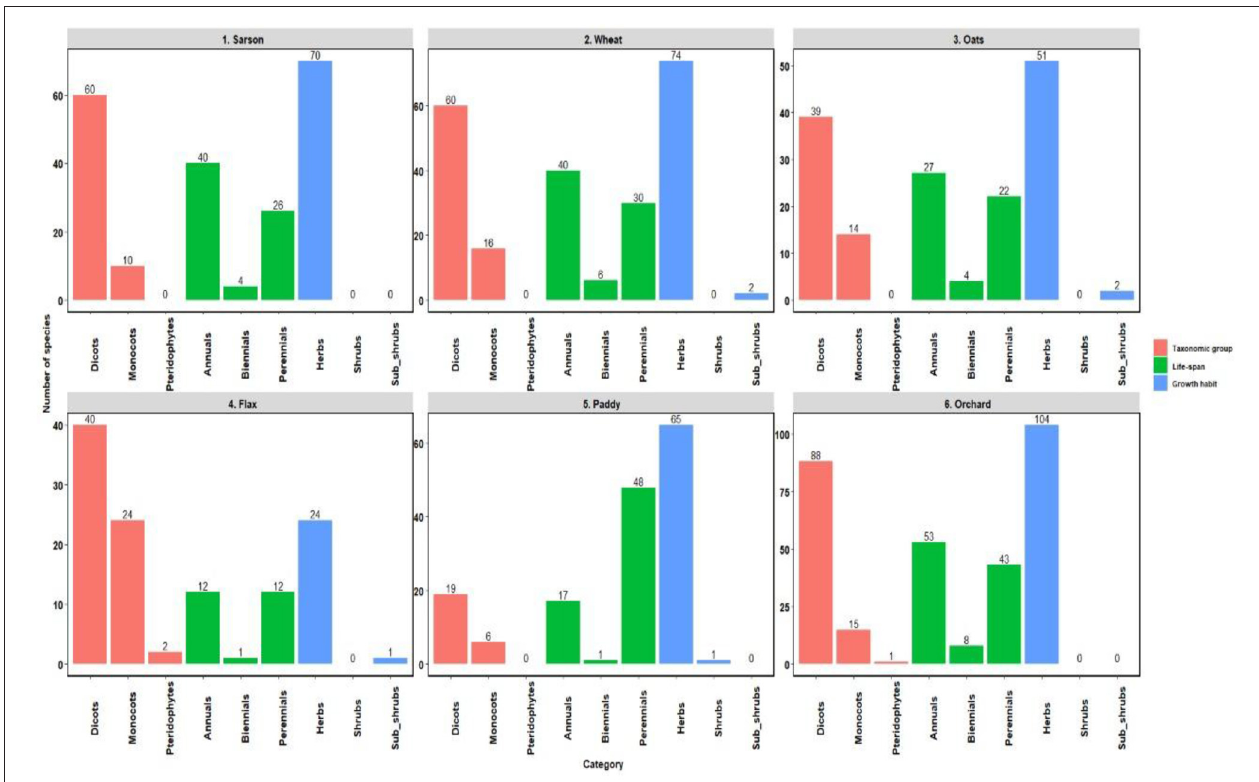
FIGURE 2 | Growth form and life span of inhabiting species and paddy.